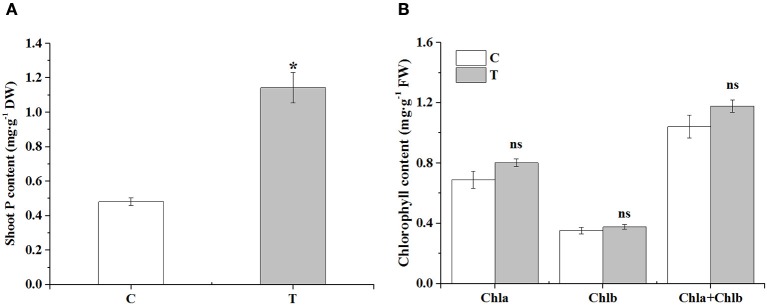
The effects of AMF on shoot P contents and leaf chlorophyll contents. (A) Shoot P contents; (B) Leaf chlorophyll contents. C: non-mycorrhizal treatment, T: mycorrhizal treatment; DW: dry weight, FW: fresh weight; “*” and “ns” mean significant difference at P < 0.05 and no significant difference, respectively.